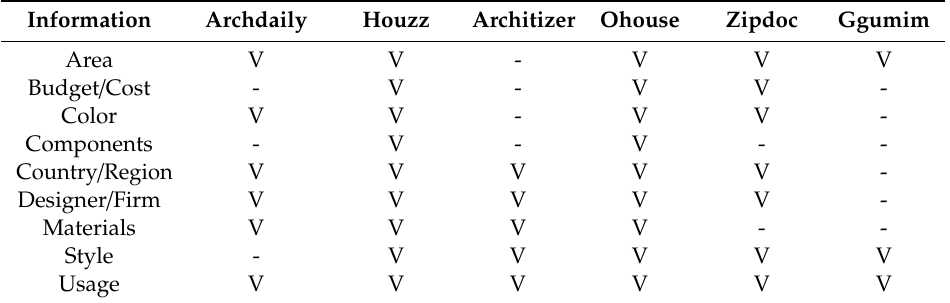
Table 1. Representative design information types provided by interior design reference image sharing platforms (“V” indicates provided and “-” indicates not